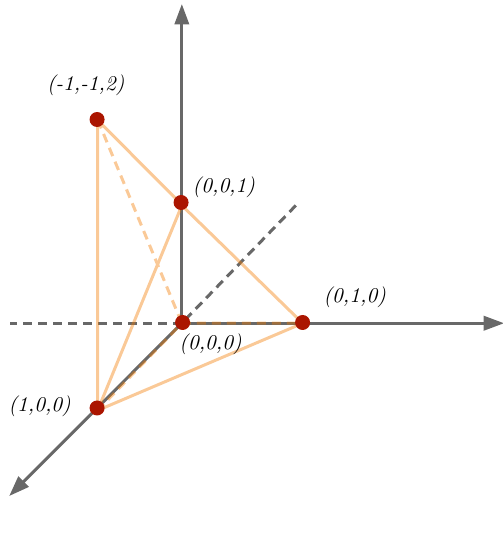
Figure 6 . Toric diagram of Y 1 , 2 ( P 2 )